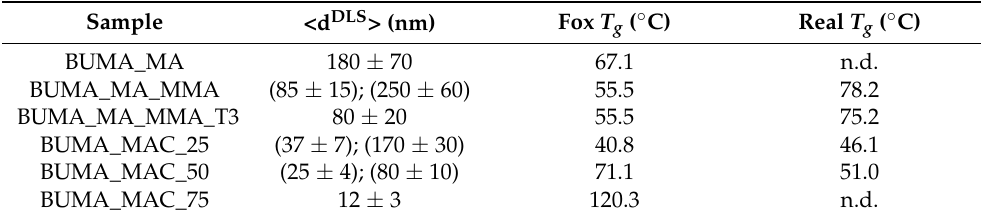
Table 2. Molar ratio of reagents adopted for the synthesis of BUMA-based polymers.